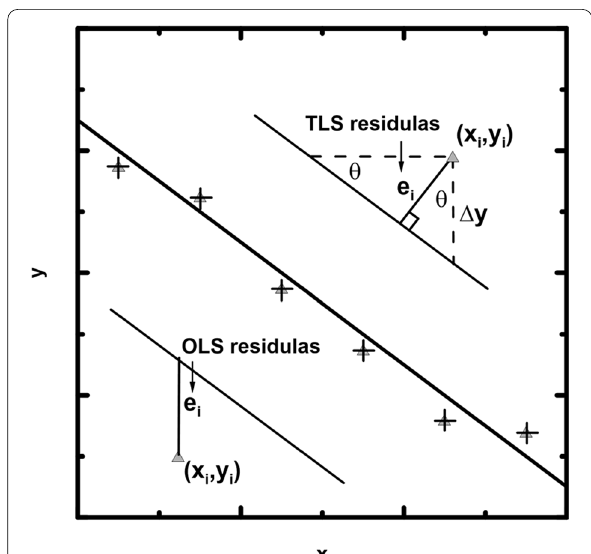
Fig. 1 Schematic comparison between ordinary least squares (OLS) and total least squares (TLS). The solid line in the middle of the plot is a fitting line model of y a = +